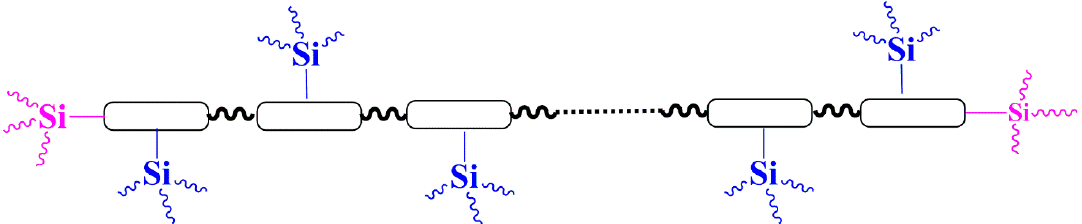
Figure 2. PU modified with siloxane in both backbone and side chains.